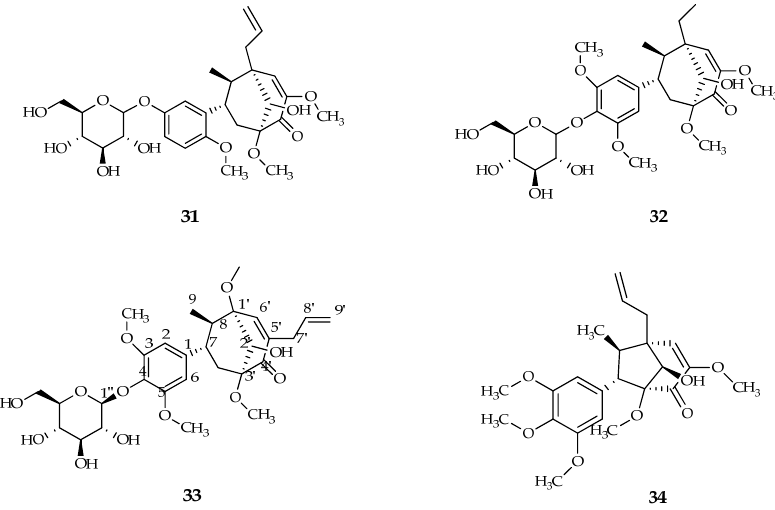
Figure 8. Compounds obtained from the methanolic extract of red betel leaf. ( 31 ) Pipcroside A; ( 32 ) Pipcroside B; ( 33 ) Pipcroside C; and ( 34 ) Bicyclo [3.2.1] octanoid neolignans. Table 1. Bioactivity of isolated Piper